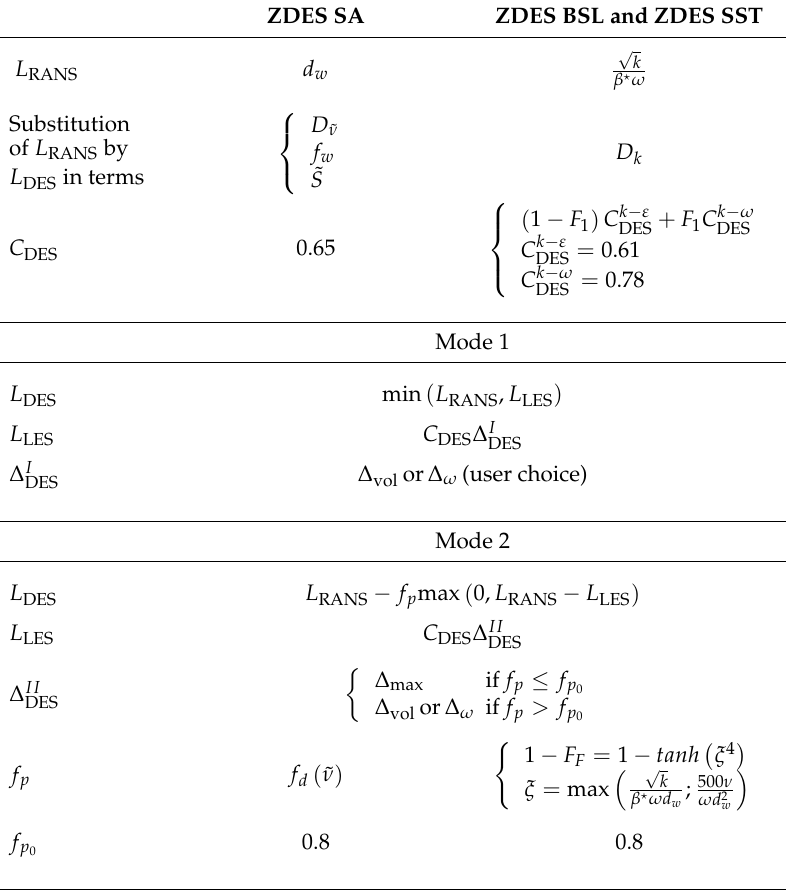
Table 2. Differences between ZDES approaches depending on the underlying turbulence model and the selected mode (mode numbers are relative to those defined in Figure 4). d w is wall distance and all terms refer to original RANS formulation (e.g., D k or D ˜ ν